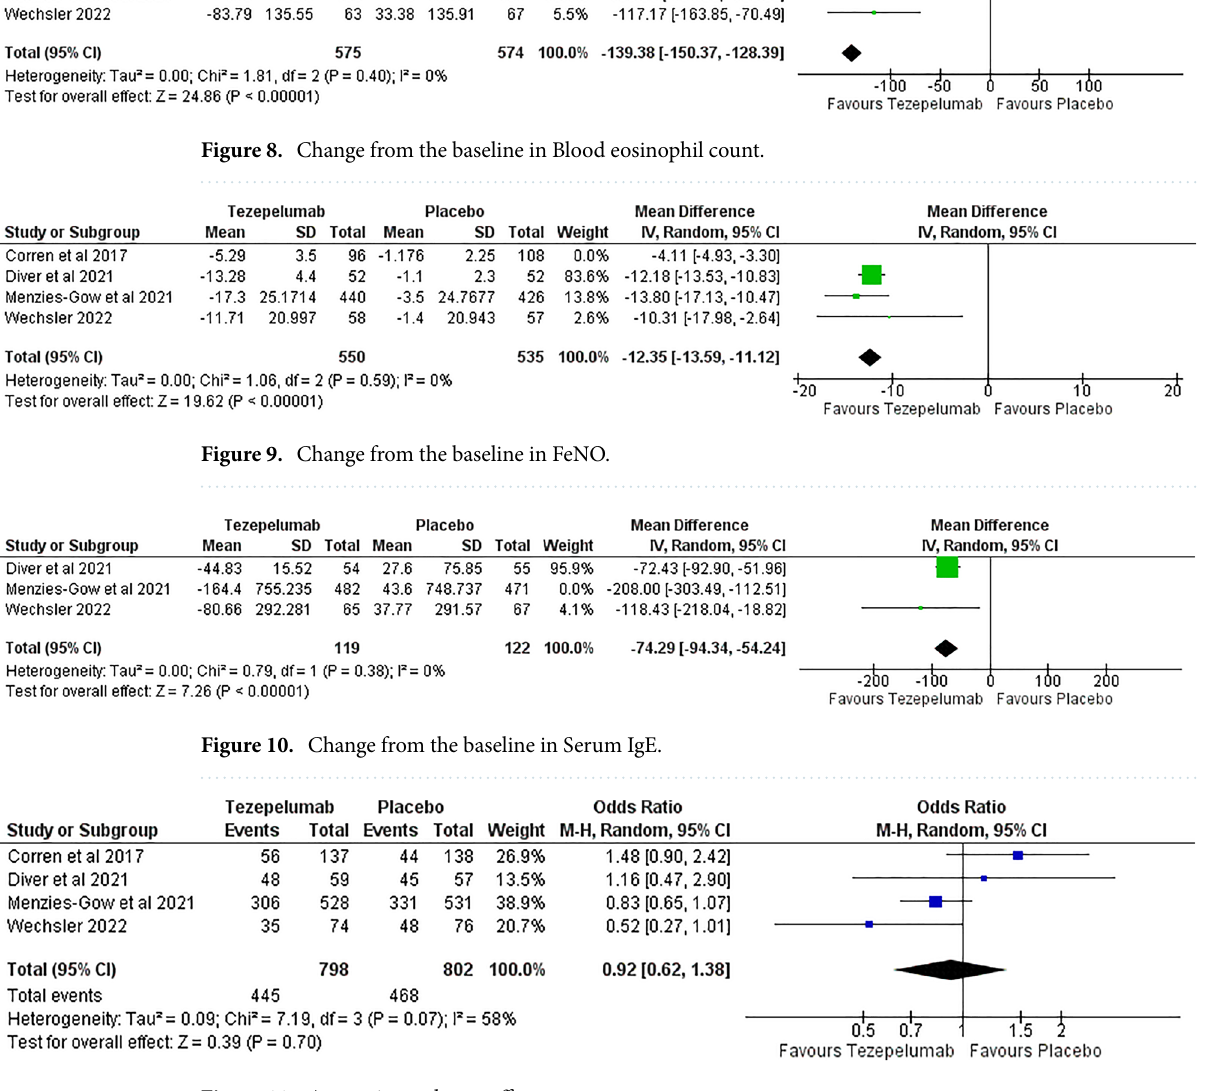
Figure 11. Any serious adverse effects